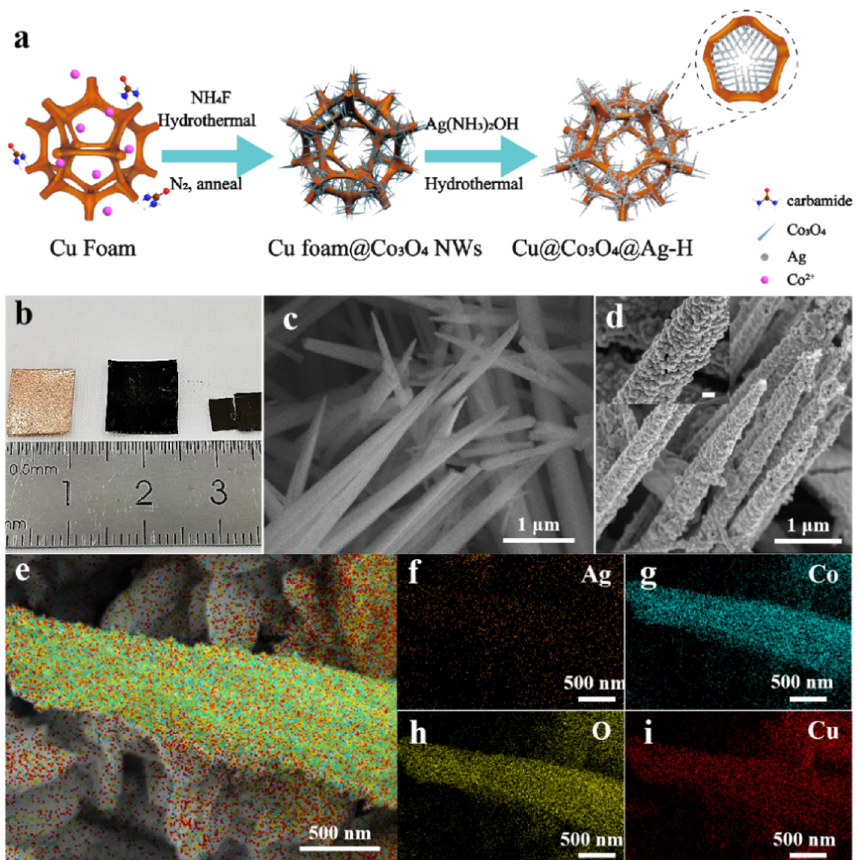
Figure 1. ( a ) Schematic illustration of the fabrication process toward hierarchical Cu@Co 3 O 4 @Ag-H substrate. ( b ) Photographs of Cu Foam (left), Cu@Co 3 O 4 NWs (mid), Cu@Co 3 O 4 @Ag-H (right). ( c , d ) Corresponding SEM images of Cu@Co 3 O 4 NWs and Cu@Co 3 O 4 @Ag-H. The scale bar in insert of ( d ) is 100 nm. ( e – i ) SEM elemental mappings of Cu@Co 3 O 4 @Ag-H: ( e ) the overlay selected square area of